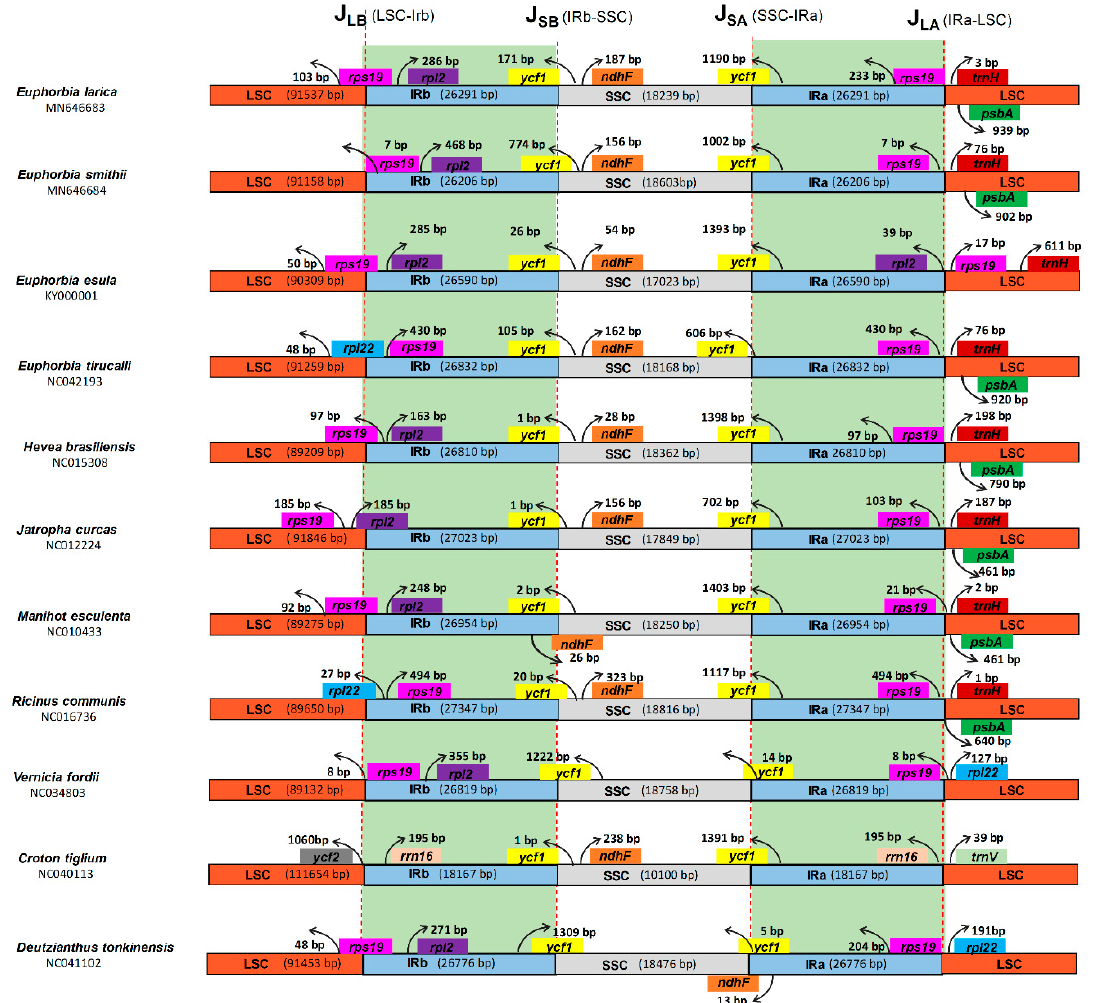
Figure 4. Distances between adjacent genes and junctions of the small single-copy (SSC), large single- copy (LSC), and two inverted repeat (IR) regions among plastid genomes E. smithii and E. larica and related species within the Euphorbiaceae family . Boxes above and below the primary line indicate the adjacent border genes. The figure is not to scale with regards to sequence length and only shows relative changes at or near the IR/SC borders.